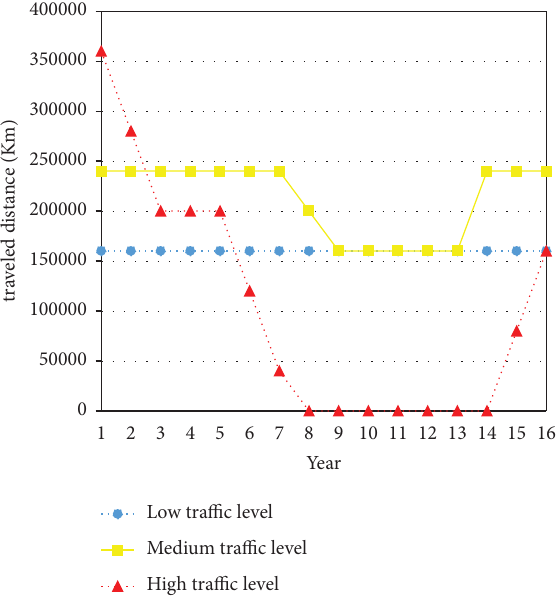
Figure 5: Traveled distance of diesel vehicles for diferent levels of trafc congestion.